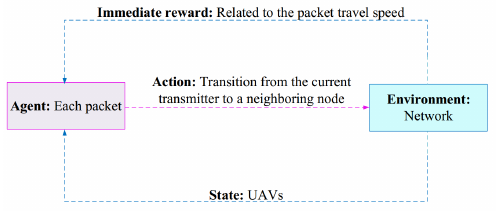
Figure 30. Learning process in QGeo. Table 12. The most important advantages and disadvantages of